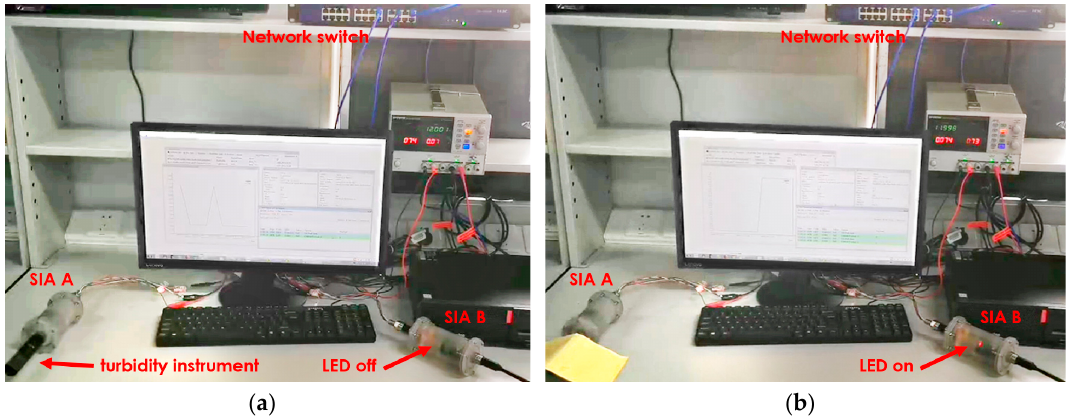
Figure 10. Photos of laboratory test setups: ( a ) The SIAs are just powered up; ( b ) The instrument connected to the SIA A is shaded.